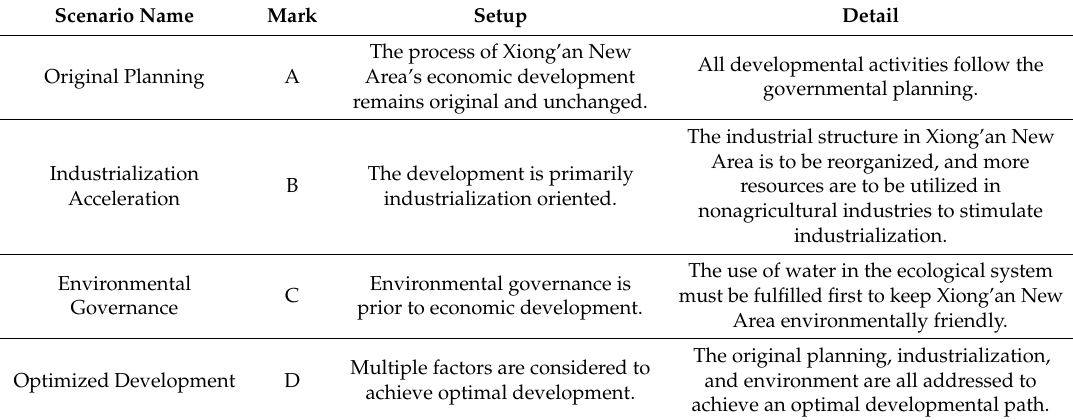
Table 1. Simulation scenarios of Xiong’an New Area’s water resources carrying